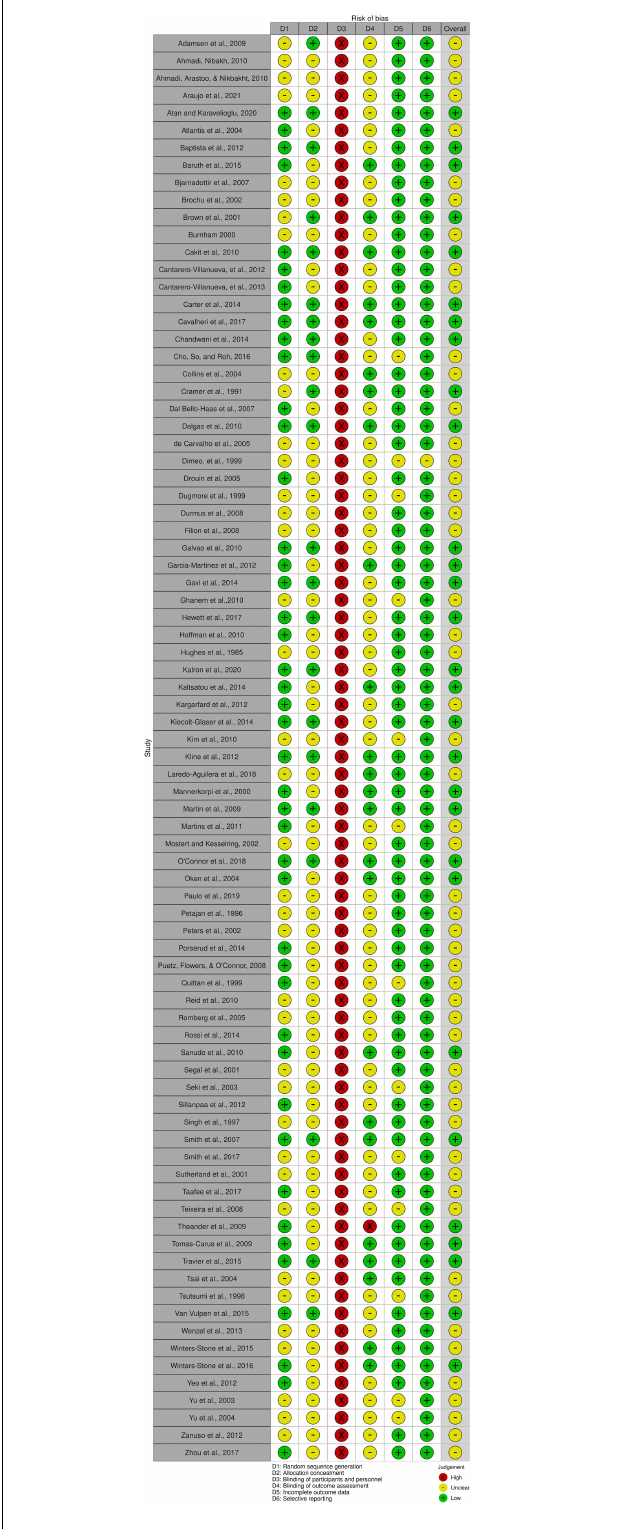
FIGURE 2 | Risk of bias of each included study. The risk of bias of each criterion measured by the Cochrane Risk of Bias tool and the total risk of bias for each individual study. Graphic by the RoB2